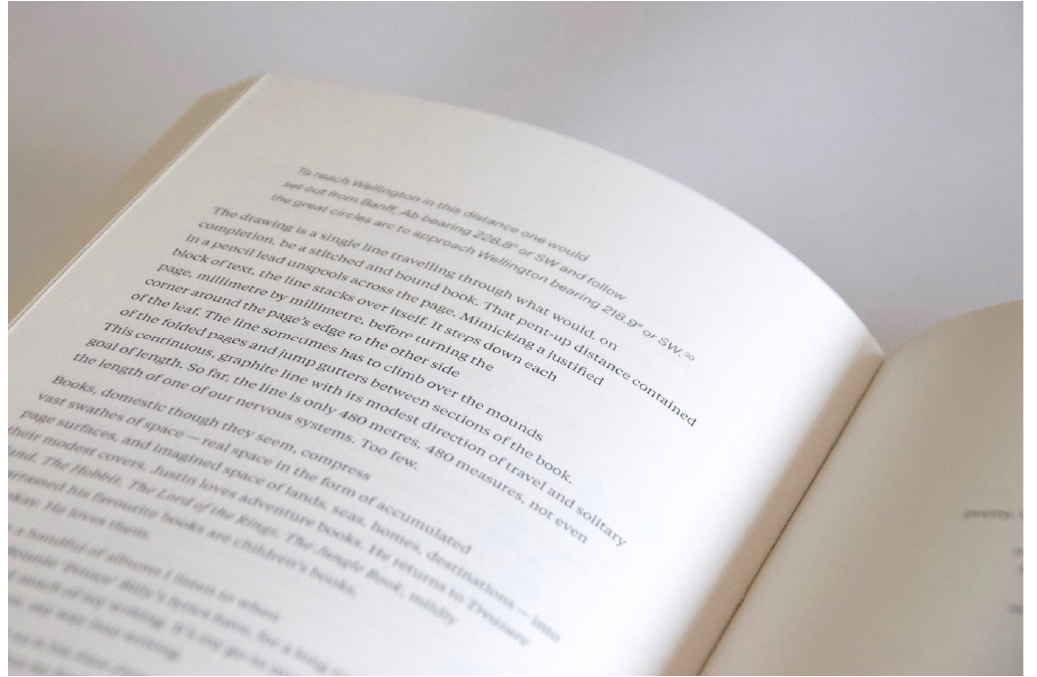
Figure 12. Elsewhere, or at sea , 2022. Inside detail of part of the essay A line that, in theory, could connect us . Limited edition artist book.